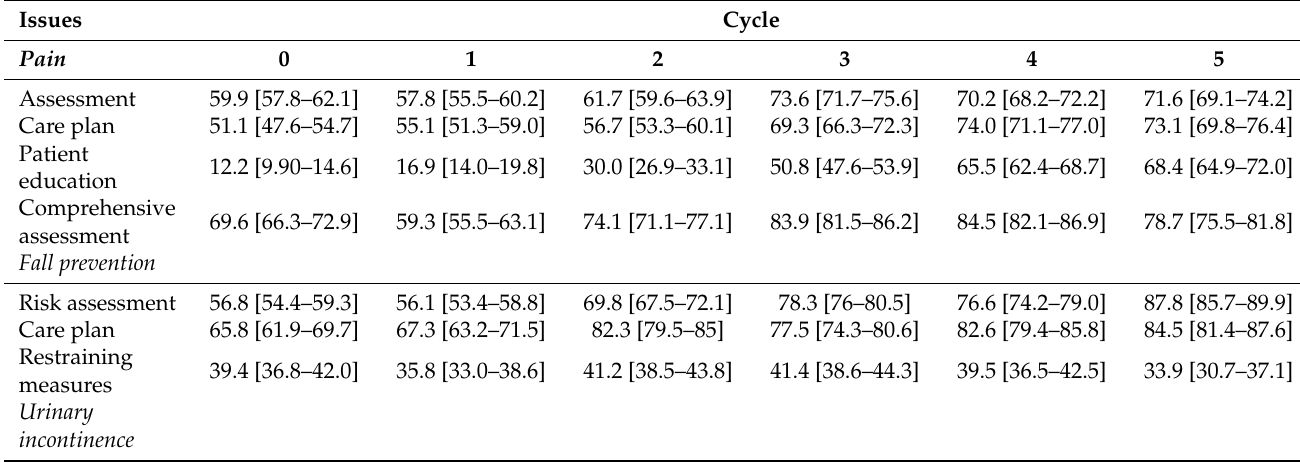
Table 2. Percentages (95% CI) of compliance for each item in the